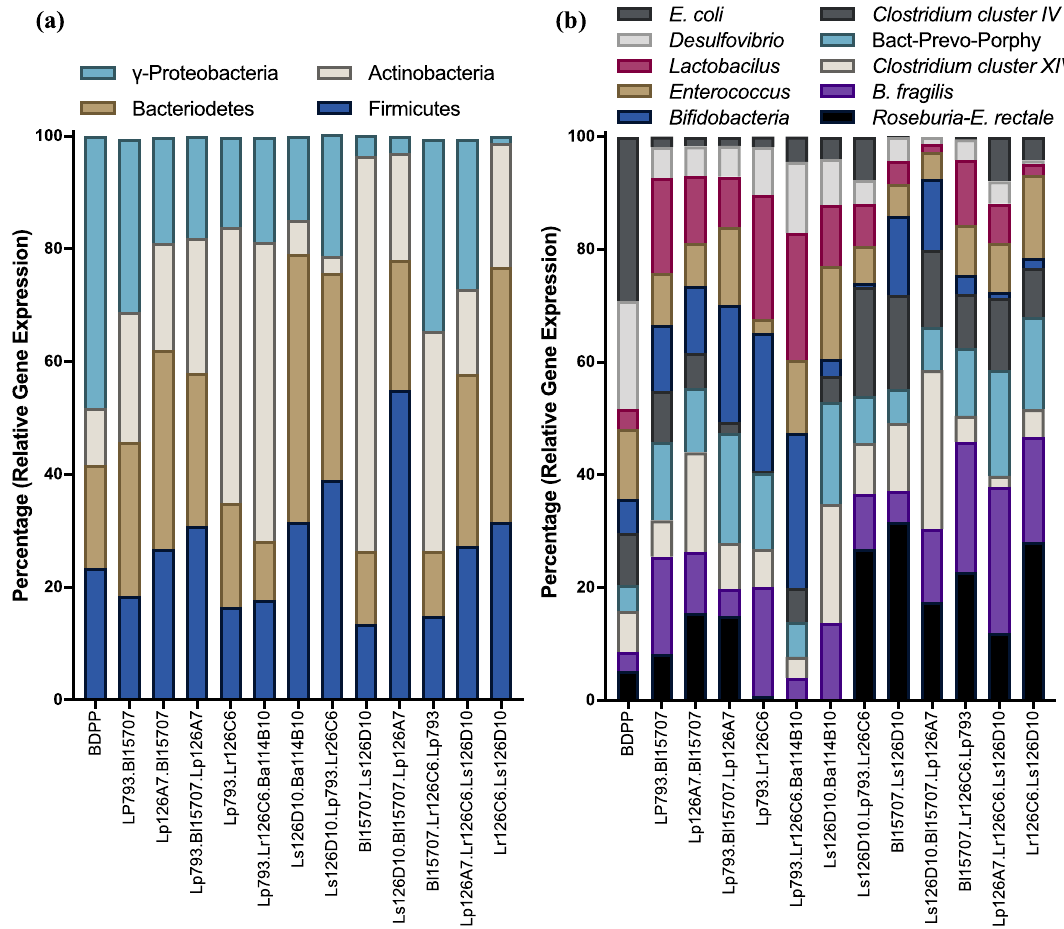
Figure 5. Relative gut microbiome population variations in the abiome following probiotic treatment. A representation of select gut microbiome ( a ) phyla and ( b ) genera from ABIOME inoculated with human fecal matter and subsequently treated with combinations of novel probiotics is presented. Populations were calculated using 16S qPCR rRNA analysis of the V1-V3 region of each of the groups and represented using the 2 −ΔΔCT method relative to a reference sample and the total amount of bacteria as determined by the 27F/519R primer set. Across combination, the relative gene expression is shown as a percentage of the total relative populations. Each sample represents n = 3 trials and between-group analysis was calculated using the Mann Whitney